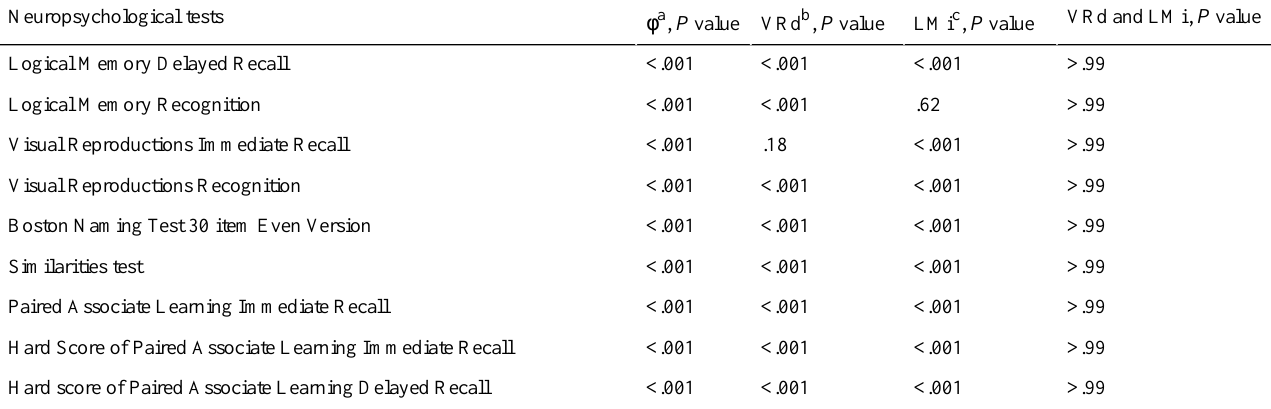
Table 2. The P values of association between neuropsychological (NP) tests and cognitive status when conditioning on NP tests in Markov blanket. The significant degree was computed using Pearson chi-square test with adjusted degrees of freedom.